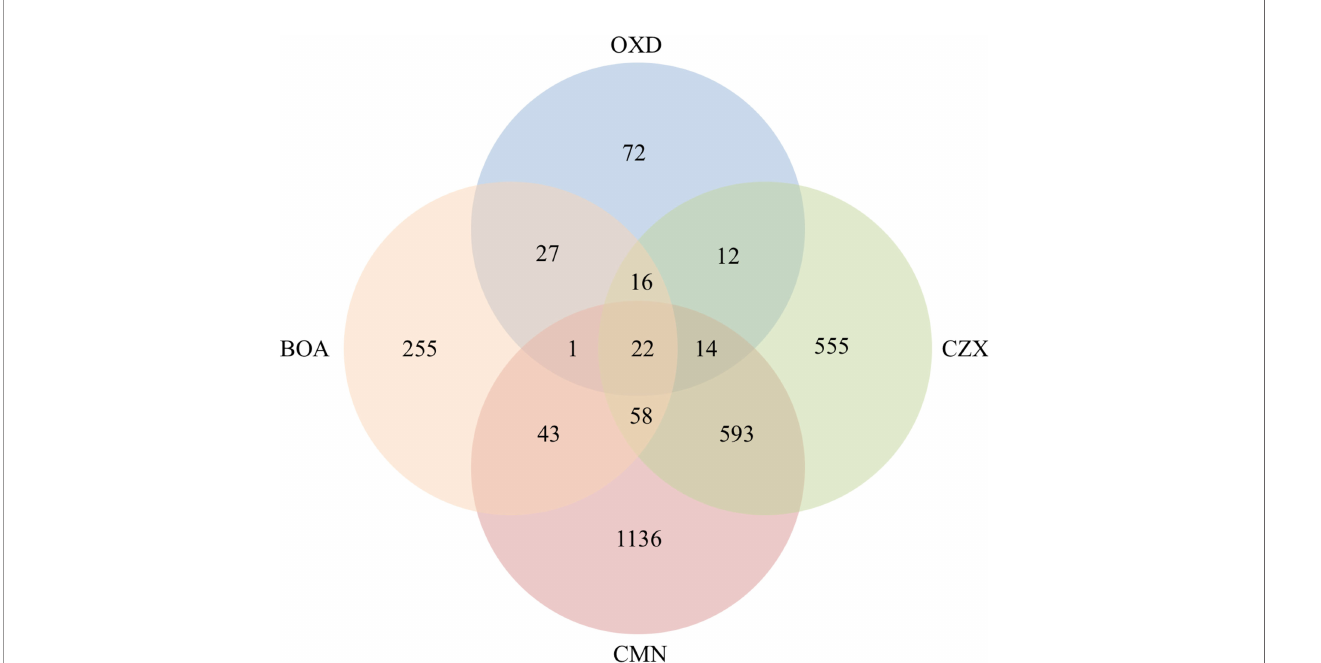
FIGURE 3 | Co-upregulated genes were observed among BOA, OXD, CMN, and CZX treatments. Venn diagram shows the number of genes with altered expression due to BOA, OXD, CMN, or CZX exposure. Each circle represents one chemical treatment. Overlaps represent up-regulated genes shared between corresponding treatments.